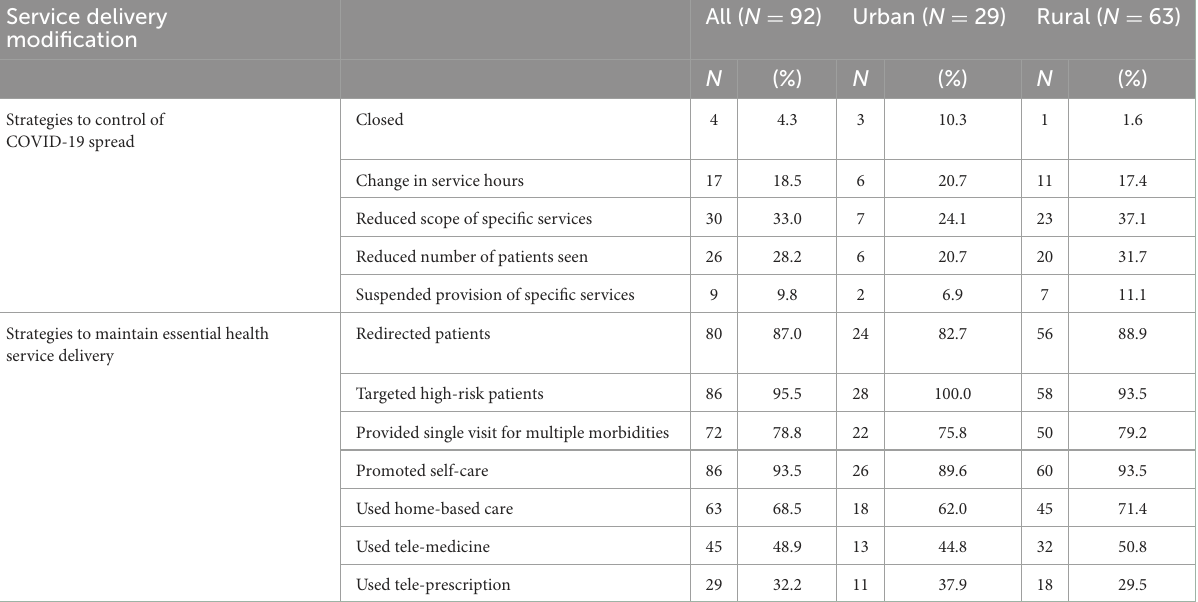
TABLE 3 Facilities that modified service delivery during the months November 2021-January 2022, Afghanistan ( N =